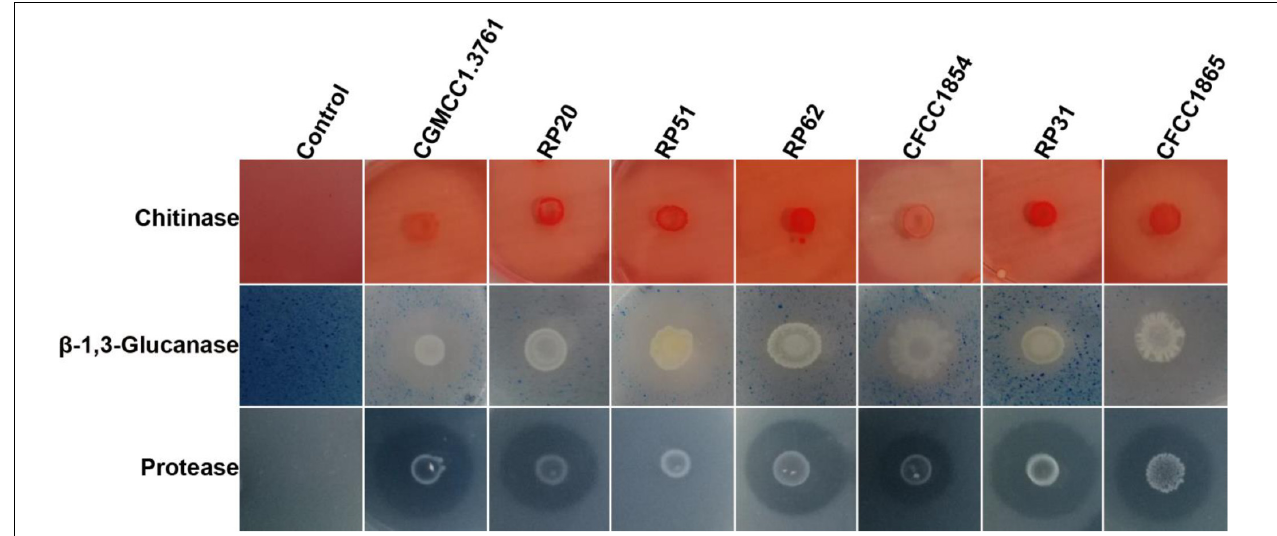
FIGURE 2 | Agar plate assays show hydrolysis of chitin, β -1,3-glucan, and casein by chitinase, β -1,3-glucanase, and protease from P. peoriae CGMCC 1.3761 T and nodule-inhabiting strains within Paenibacillus polymyxa complex.